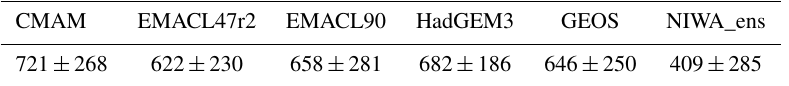
Table 2. The change in the mean distance (in geopotential meters) between the 1 and 100hPa levels in the tropics between the 1960s and the 2090s for the analyzed REF-C2 CCMI-1